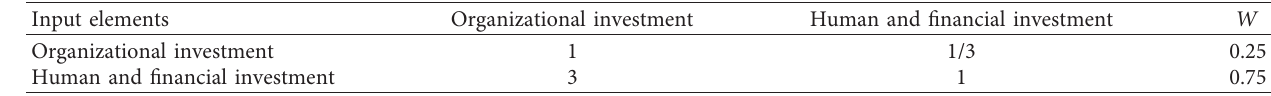
Table 2: Judgment matrix of secondary indicators of knowledge supply chain-input elements.